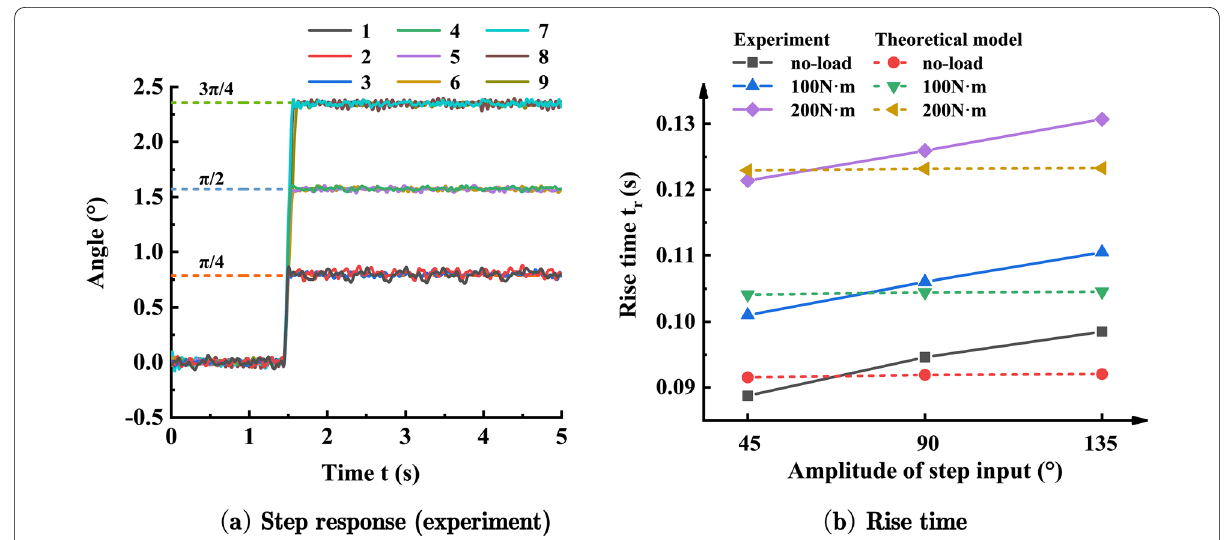
Figure 10 Step response test curve and rise time under nine operating conditions